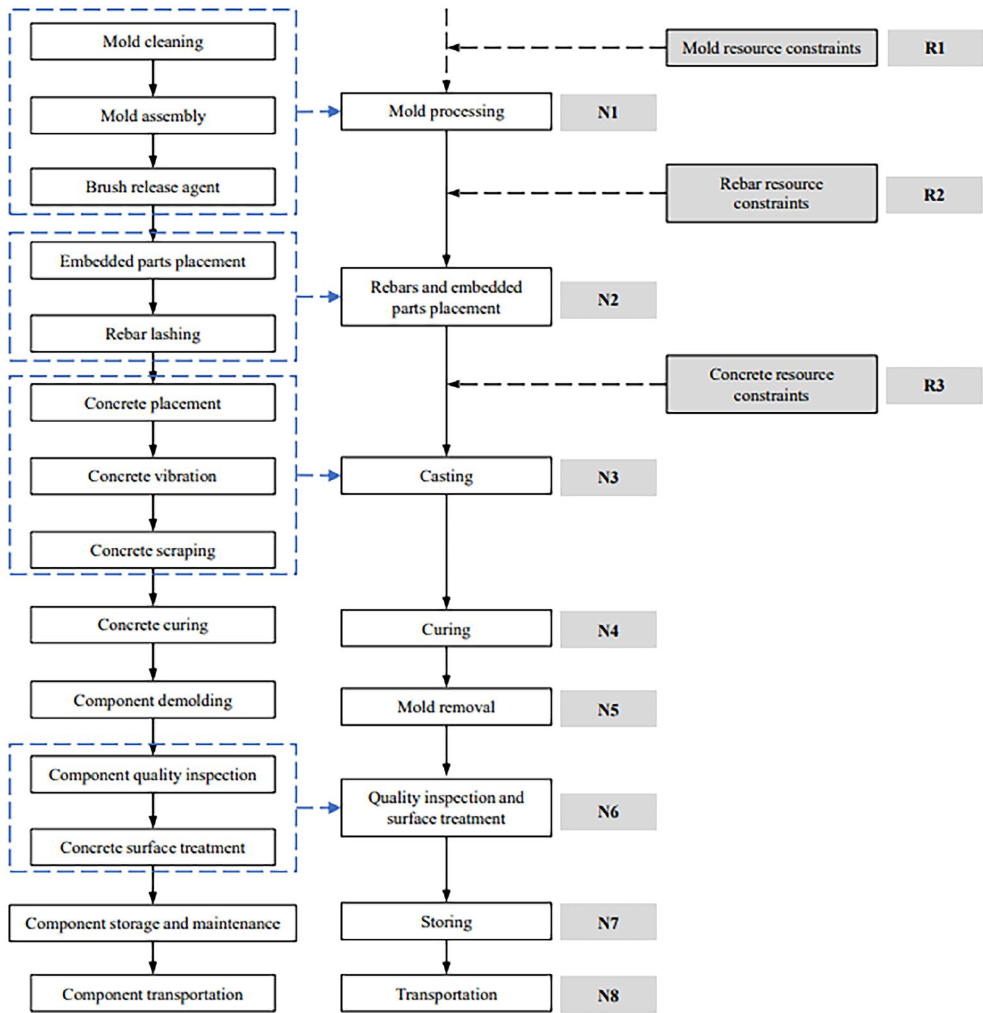
Figure 2. Precast component production eight-process model